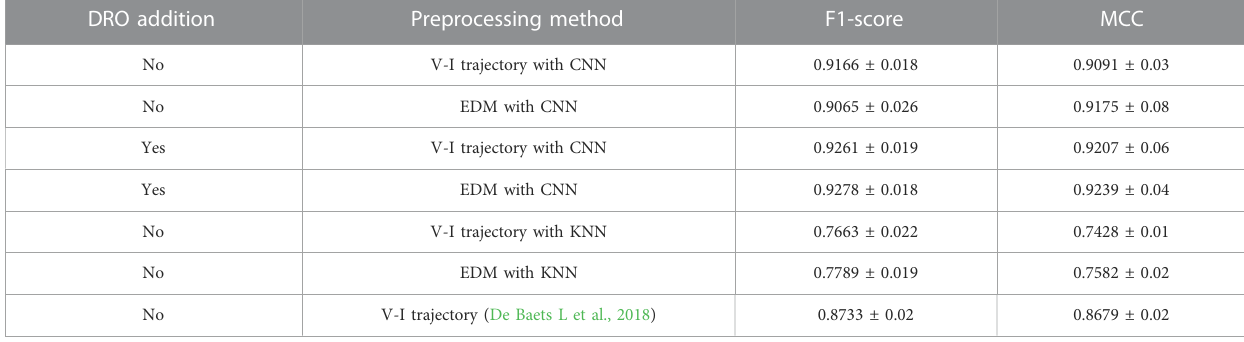
TABLE 1 Summary of the results of the two preprocessing methods combined with the DRO model under the PLAID. DRO